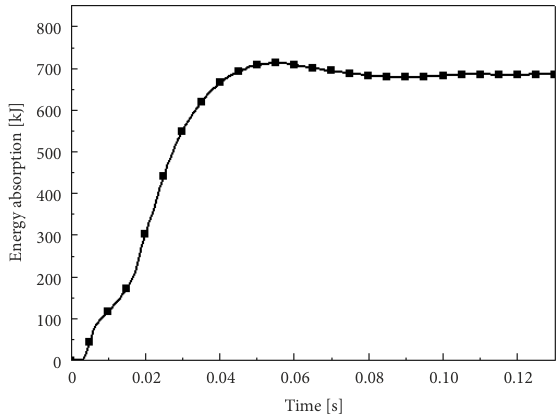
Figure 11. Energy absorption characteristic curve of the vehicle